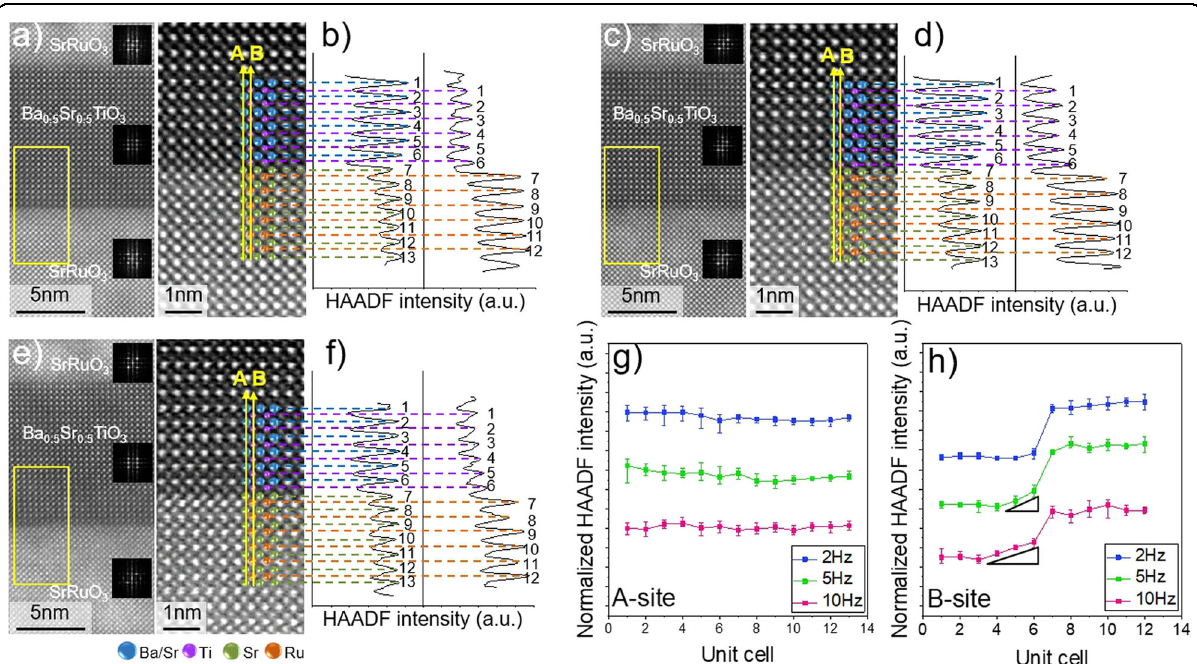
Fig. 2 Interface characterization of the SrRuO 3 /Ba 0.5 Sr 0.5 TiO 3 /SrRuO 3 capacitor. a, c, e Cross-sectional HAADF-STEM images for capacitors with SrRuO 3 electrodes grown at 2, 5, and 10 Hz, respectively; the insets show the FFT pattern of each layer. b , d , f HAADF intensity pro fi les for sites A and B, which were gathered from high-magni fi cation HAADF-STEM images of the devices fabricated at 2, 5, and 10 Hz, respectively. g A- and h B-site peak intensities extracted from the HAADF intensity pro fi les as a function of the number of unit